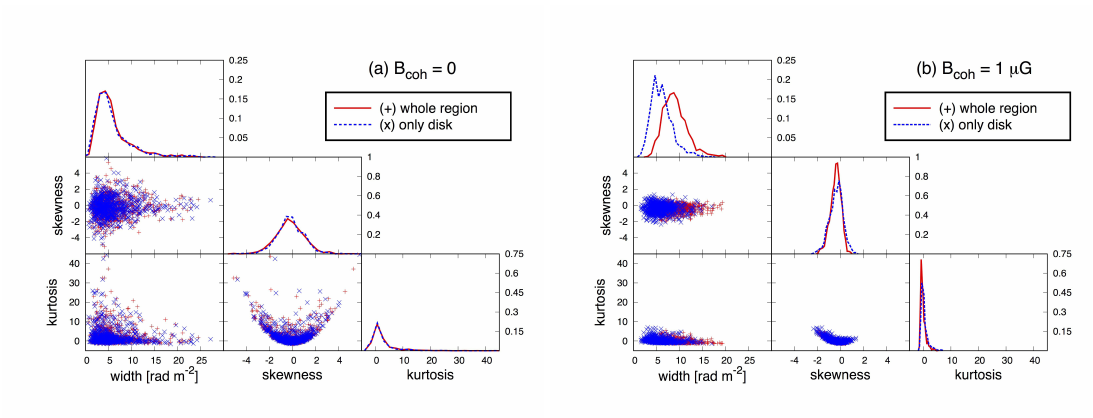
Figure 3. ( a ) Scatter plots for shape-characterizing parameters of the Faraday spectrum, F ( φ ) , for the “ B coh = 0” case ( left panels) and for the “ B coh = 1 µ G” case ( right panels). The F ( φ ) calculated from whole region and from only disk shown in red (solid line, plus symbol) and blue (dashed line, cross symbol), respectively. Eight hundred realizations are shown. Top panels of each column are one-dimensional probability distributions of the